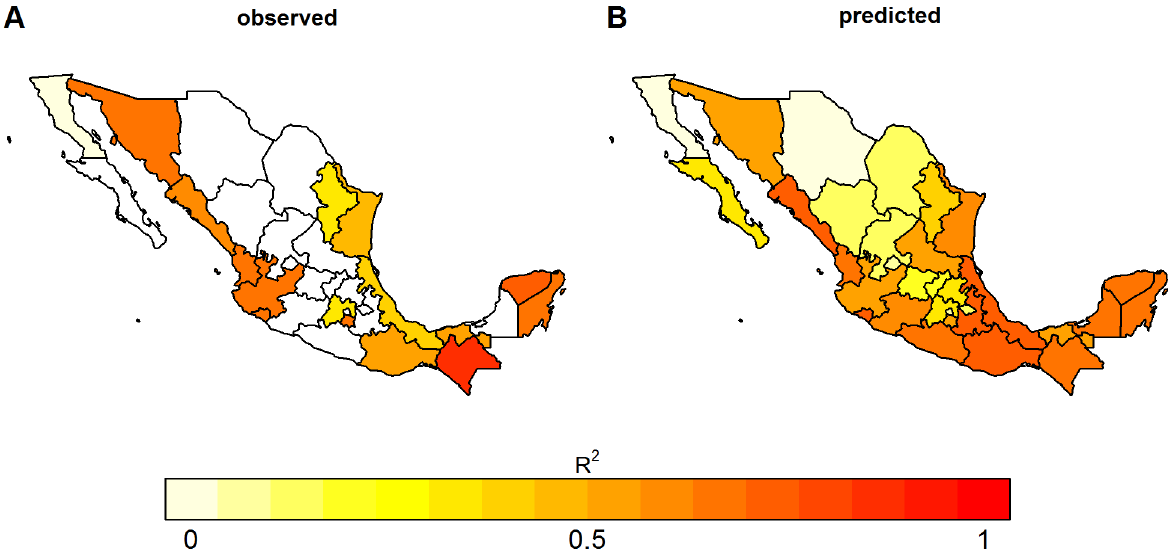
Figure 2. Observed and model-estimated R 2 for GDT and reported dengue cases. Darker shading indicates a higher coefficient of determination between GDT and traditional surveillance data from observed data (A) and for predictions from the model using maximum temperature, precipitation and the interaction of those two variables (B).